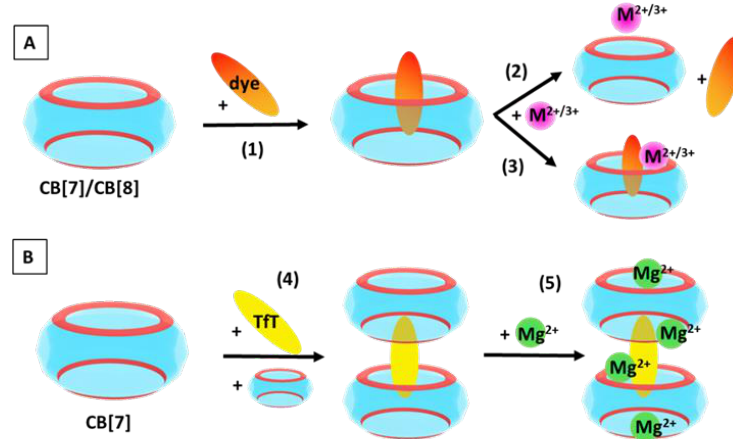
Figure 1. General scheme of the reactions modelled in the current study. ( A ) Formation of host:guest complexes: CB[7/8]@dye according to (1); CB[7/8]@M 2+/3+ (competitive binding of metal cations in 2+/3+ oxidation state) according to (2); ternary CB[7/8]@dye@M 2+/3+ structures (cooperative association